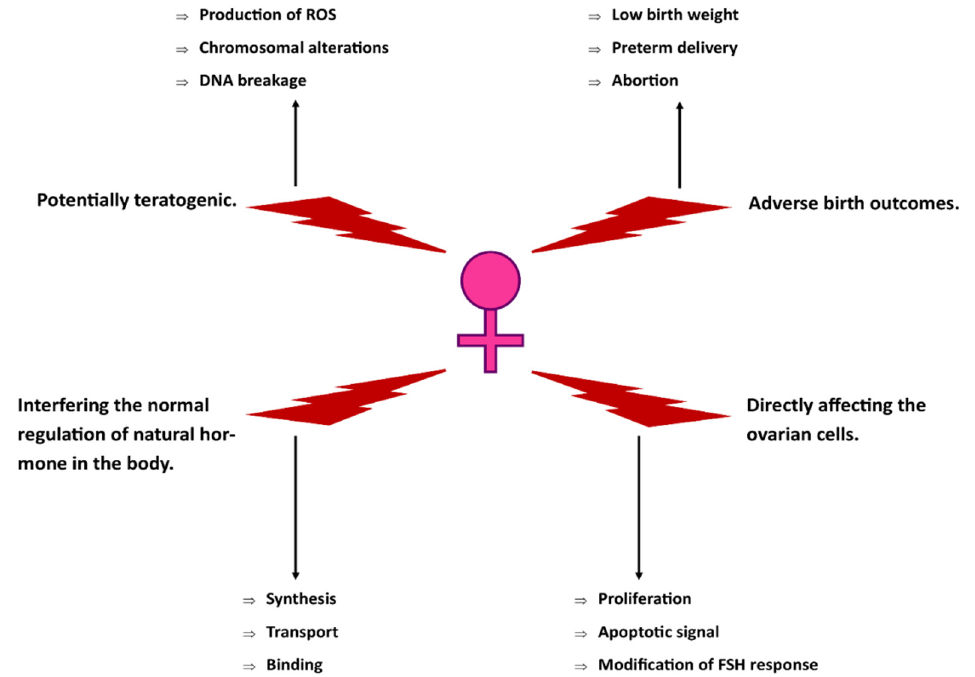
Figure 3. Suggested toxicity mechanisms of technical xylene on the female reproductive system.